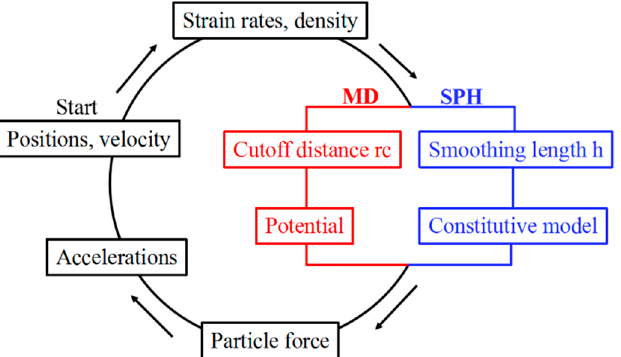
Figure 1. Comparison of calculation procedure between the MD and SPH methods.